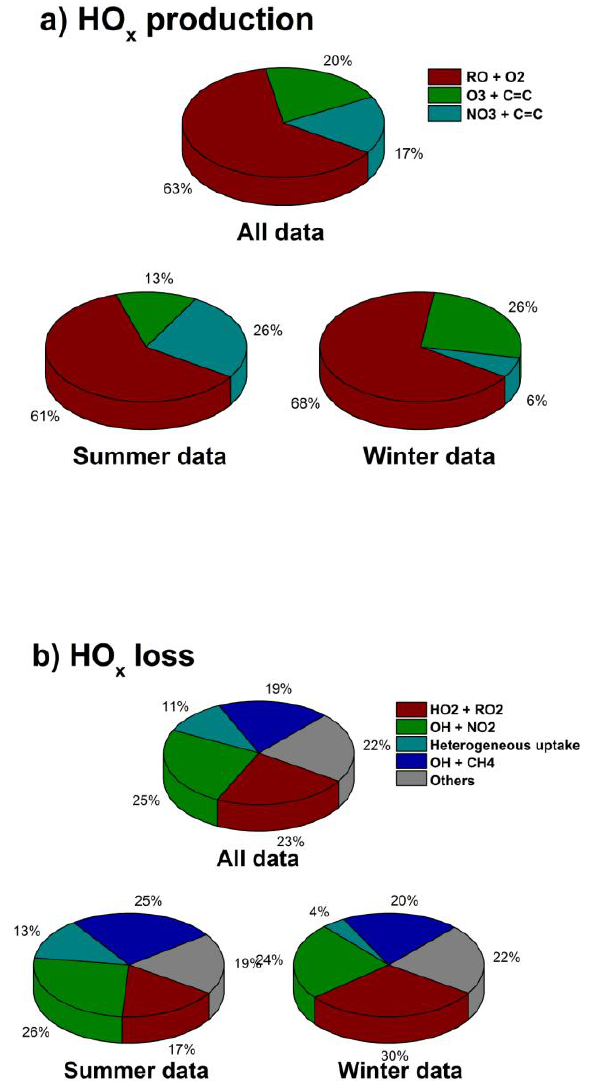
Fig. 8. Reactivity of (a) NO 3 and (b) O 3 towards observed VOCs Fig. 9. Processes controlling the instantaneous production (a) and at night during the RONOCO project. The upper panels show the loss (b) of HO x (i.e. OH + HO 2 ) radicals at night. The upper summer and winter campaign means combined, with the lower panels show the summer and winter campaign means combined, panels showing the summer campaign means (left hand side) and with the lower panels showing the summer campaign means (left Figure 8: Reactivity of (a) NO and (b) O towards observed volatile organic compounds (VOCs) at Figure 9: Processes controlling the instantaneous production (a) and loss (b) of HO (= OH + HO ) winter campaign means (right hand side). The average NO 3 re- 3 3 x 2 hand side) and winter campaign means (right hand side). The aver- activity towards VOCs was 6.6 × 10 4 cm − 3 s − 1 (median = 5.3 night during the RONOCO project. The upper panels show the summer and winter campaign means radicals at night. The upper panels show the summer and winter campaign means combined, with the age total production rate of HO x was (6.7 ± 4.7) × 10 4 cm − 3 s − 1 × 10 4 cm − 3 s − 1 ) for the entire data set, 6.8 × 10 4 cm − 3 s − 1 (median = 5.7 × 10 4 cm − 3 s − 1 ) for the entire data set, combined, with the lower panels showing the summer campaign means (left hand side) and winter lower panels showing the summer campaign means (left hand side) and winter campaign means (right (median = 4.6 × 10 4 cm − 3 s − 1 ) for the summer campaign and (7.4 ± 5.7) × 10 4 cm − 3 s − 1 (median = 5.7 × 10 4 cm − 3 s − 1 ) for campaign means (right hand side). The average NO reactivity towards VOCs was 6.6 × 10 4 cm 3 s -1 6.2 × 10 4 cm − 3 s − 1 (median = 6.0 × 10 4 cm − 3 s − 1 ) for the win- hand side). The average total production rate of HO was (6.7 ± 4.7) × 10 4 cm 3 s -1 (median = 5.7 × 10 4 3 the summer campaign and (5.7 ± 2.1) × 10 4 cm − 3 s − 1 (me- x ter campaign. The average O 3 reactivity towards VOCs was 2.1 (median = 5.3 × 10 4 cm 3 s -1 ) for the entire data set, 6.8 × 10 4 cm 3 s -1 (median = 4.6 × 10 4 cm 3 s -1 ) for dian = 5.6 × 10 4 cm − 3 s − 1 ) for the winter campaign. The av- cm 3 s -1 ) for the entire data set, (7.4 ± 5.7) × 10 4 cm 3 s -1 (median = 5.7 × 10 4 cm 3 s -1 ) for the summer × 10 4 cm − 3 s − 1 (median = 2.1 × 10 4 cm − 3 s − 1 ) for the en- erage total loss rate of HO x was (7.1 ± 4.9) × 10 4 cm − 3 s − 1 the summer campaign and 6.2 × 10 4 cm 3 s -1 (median = 6.0 × 10 4 cm 3 s -1 ) for the winter campaign. The tire data set, 1.8 × 10 4 cm − 3 s − 1 (median = 1.7 × 10 4 cm − 3 s − 1 ) campaign and (5.7 ± 2.1) × 10 4 cm 3 s -1 (median = 5.6 × 10 4 cm 3 s -1 ) for the winter campaign. The (median = 6.0 × 10 4 cm − 3 s − 1 ) for the entire data set, (7.7 ± for the summer campaign and 2.9 × 10 4 cm − 3 s − 1 (median = average O reactivity towards VOCs was 2.1 × 10 4 cm 3 s -1 (median = 2.1 × 10 4 cm 3 s -1 ) for the entire 6.0) × 10 4 cm − 3 s − 1 (median = 6.0 × 10 4 cm − 3 s − 1 ) for the sum- average total loss rate of HO was (7.1 ± 4.9) × 10 4 cm 3 s -1 (median = 6.0 × 10 4 cm 3 s -1 ) for the entire 3 x 2.6 × 10 4 cm − 3 s − 1 ) for the winter campaign. mer campaign and (6.0 ± 2.2) × 10 4 cm − 3 s − 1 (median = 5.9 × data set, 1.8 × 10 4 cm 3 s -1 (median = 1.7 × 10 4 cm 3 s -1 ) for the summer campaign and 2.9 × 10 4 cm 3 s -1 data set, (7.7 ± 6.0) × 10 4 cm 3 s -1 (median = 6.0 × 10 4 cm 3 s -1 ) for the summer campaign and (6.0 ± 2.2) 10 4 cm − 3 s − 1 ) for the winter (median = 2.6 × 10 4 cm 3 s -1 ) for the winter campaign. × 10 4 cm 3 s -1 (median = 5.9 × 10 4 cm 3 s -1 ) for the winter campaign.